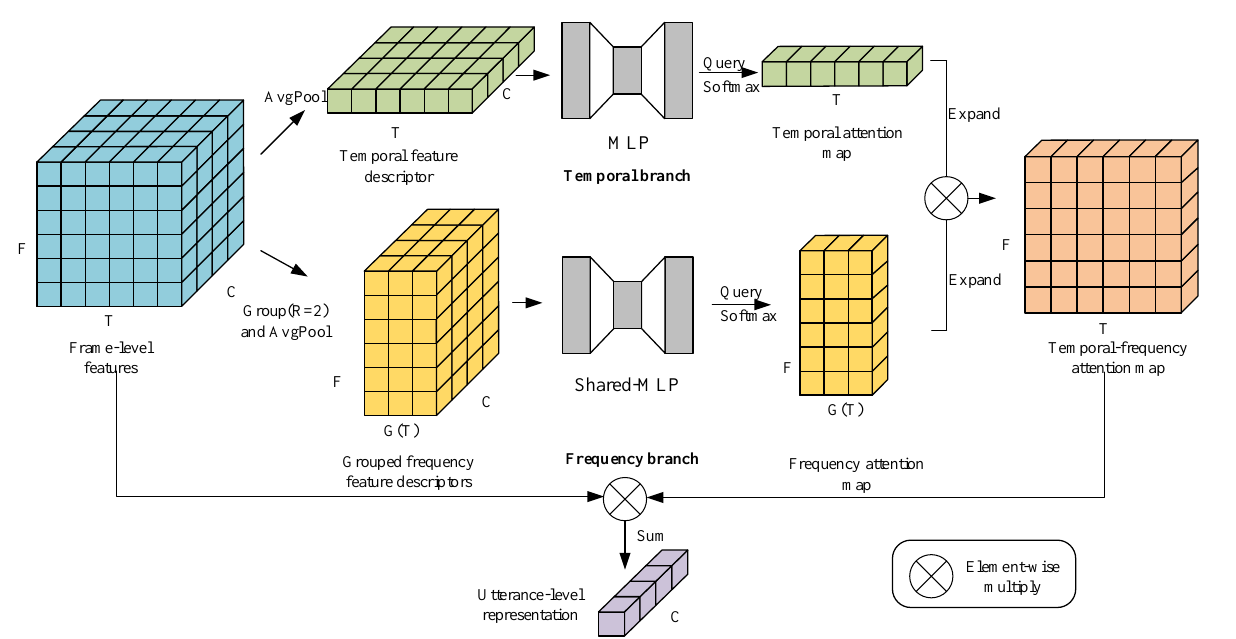
Figure 1. Diagram of the attention-based temporal-frequency aggregation